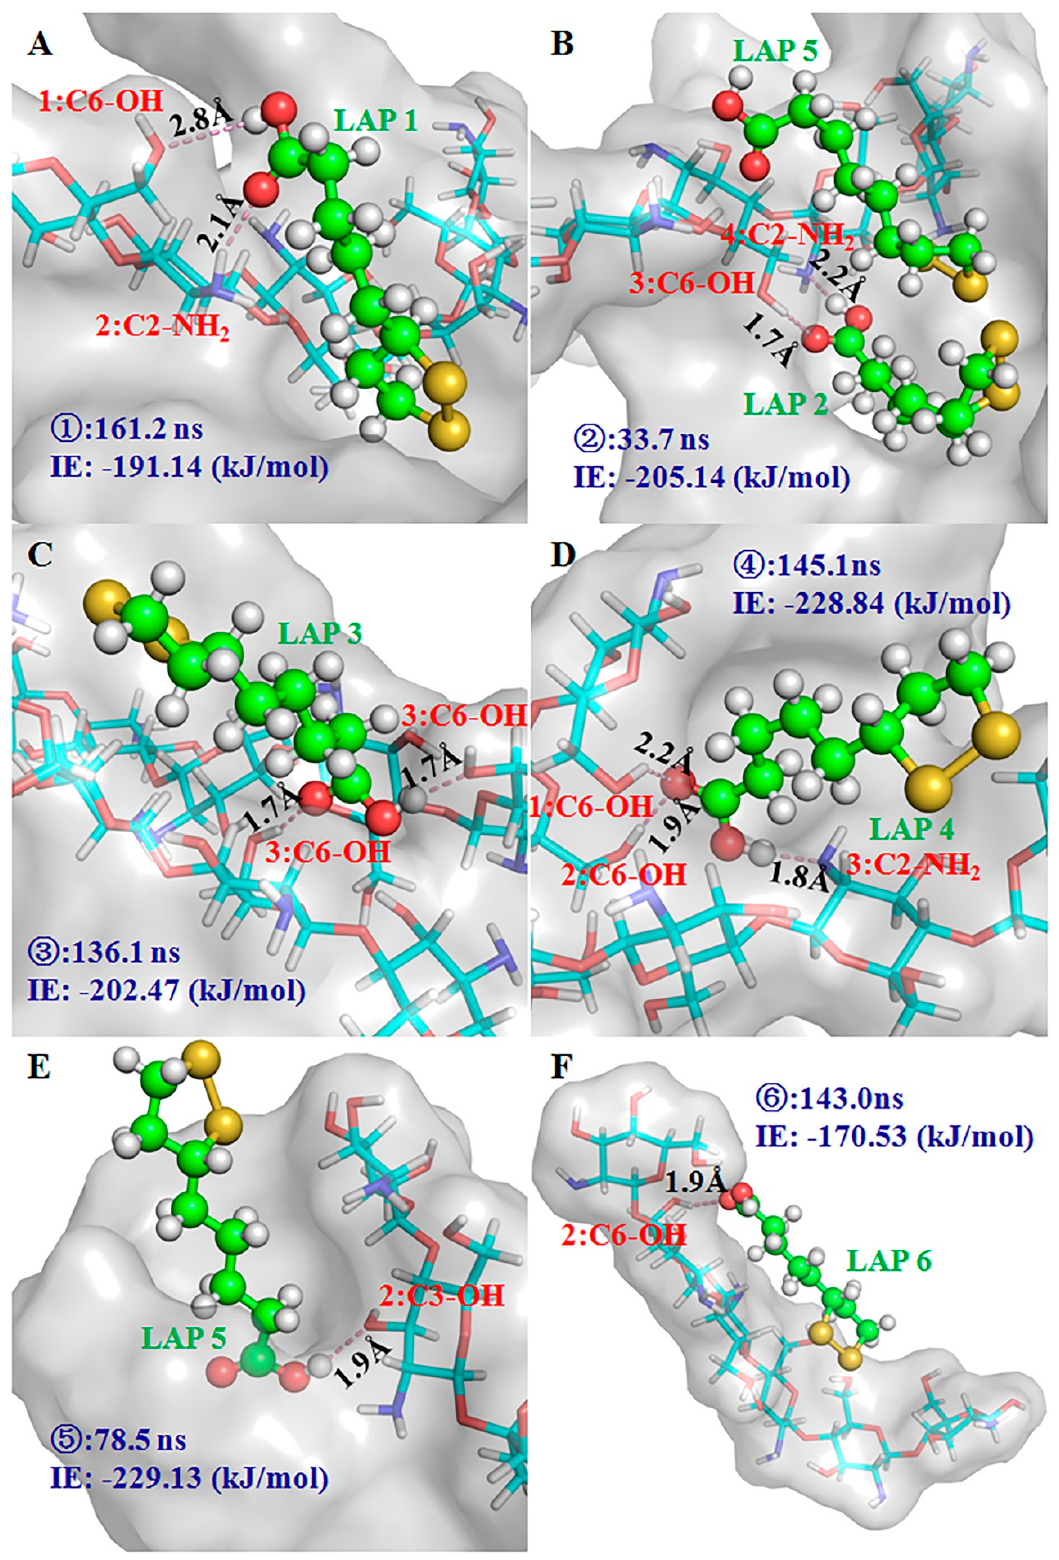
Figure 8. The conformation in the highest interaction energy snapshots. ( A – F ) ALA 1–6 are shown as a ball-and-stick model and are labeled in green; the groups of chitosan which participated in the formation of the hydrogen bond are labeled in red (unit number: carbon number-group). The chitosan presented as the gray surface and the hydrogen bonds were showed as a pink dash. The simulation time and interaction energy (IE) were labeled in blue.